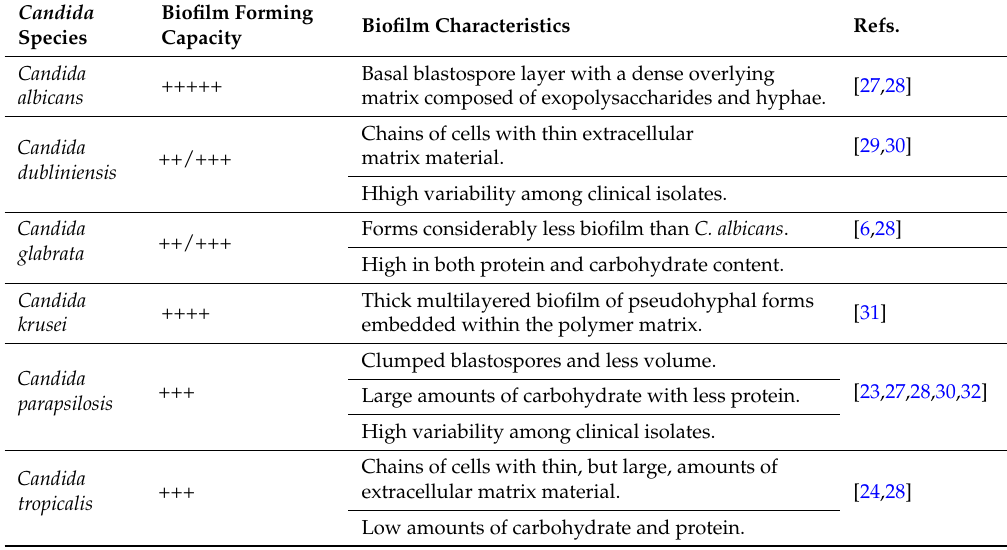
Table 1. Characteristics of the most common Candida species biofilms.